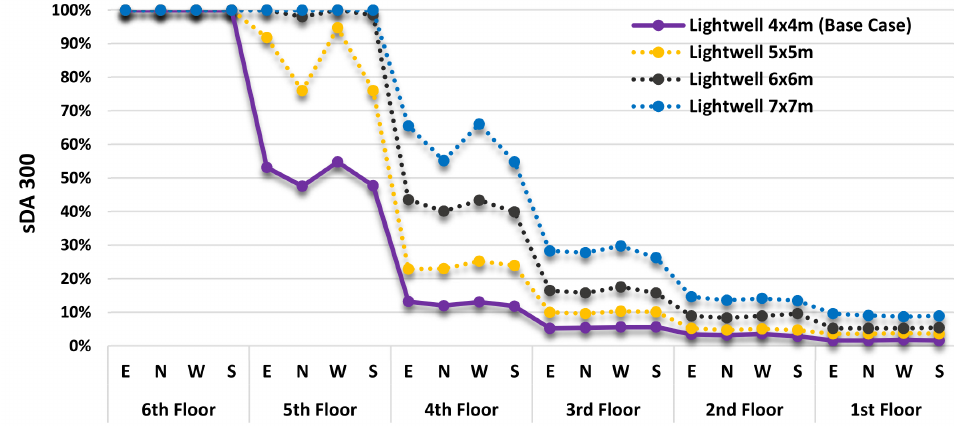
Figure 3. sDA values in the Macapa’s model at different lightwell